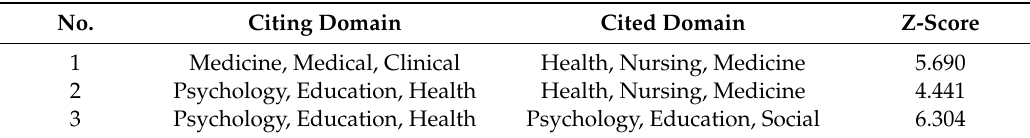
Table 6. Citation trends of risk communication at a domain